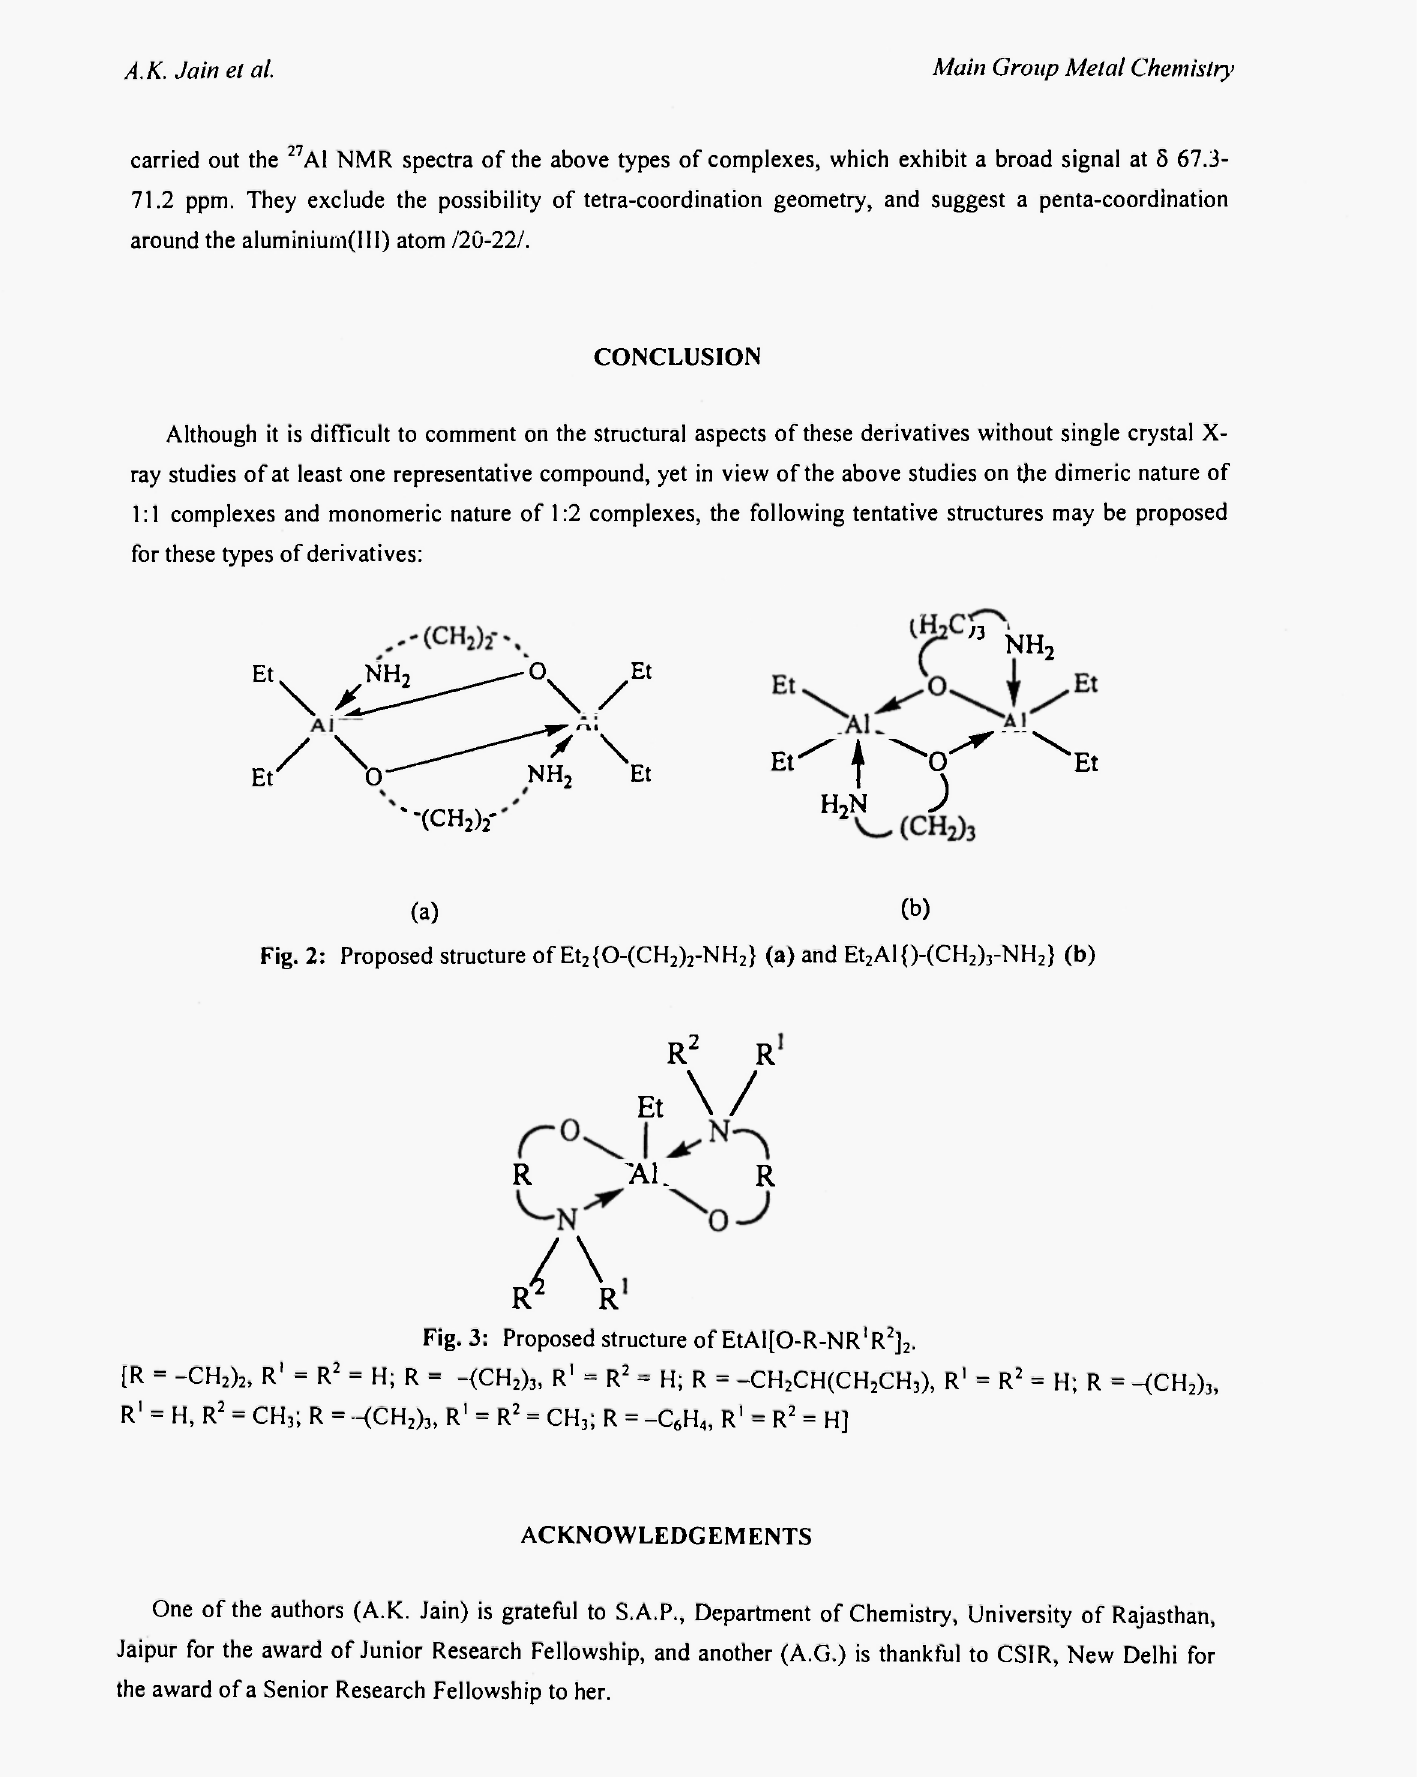
Fig. 3: Proposed structure of EtAI[0-R-NR'R 2 ] 2